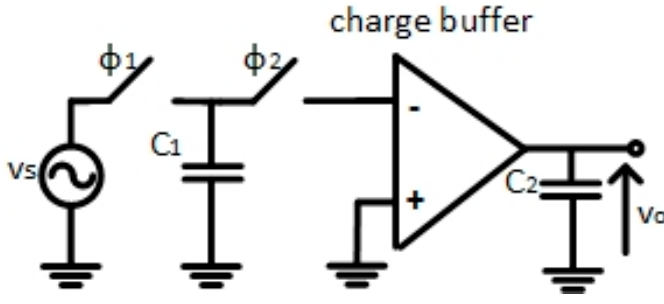
Figure 6. Schematic of the proposed open-loop switched-capacitor integrator.